Question: Write the caption for this figure.
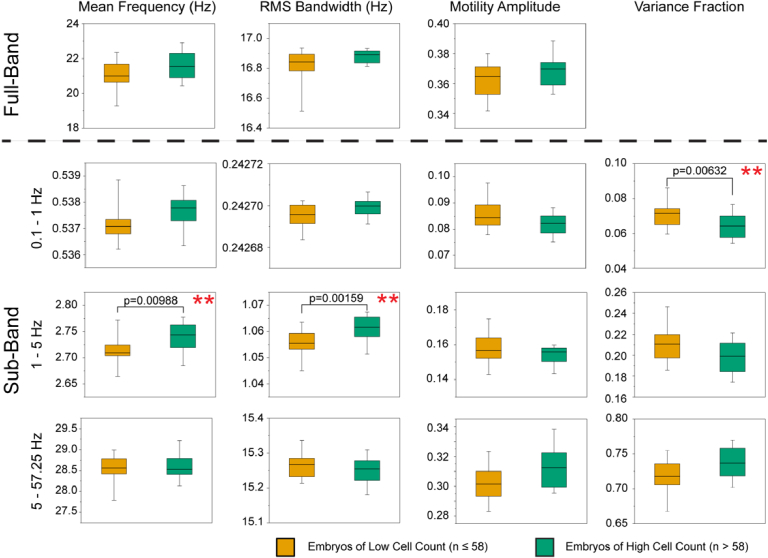
Answer: Comparison of band-resolved dOCM motility metrics between lower- and higher-cell-count blastocysts . Box plots illustrate the distribution of Mean Frequency, RMS Bandwidth, Motility Amplitude, and Variance Fraction derived from the full frequency spectrum (top row) and three distinct sub-bands: 0.1–1 Hz, 1–5 Hz, and 5–57.25 Hz. The cohort was stratified into two independent groups based on the median cell count: low-cell-count blastocysts (n ≤ 58, orange) and high-cell-count blastocysts (n > 58, green). Group differences were assessed using the two-tailed Mann-Whitney U test, with Benjamini-Hochberg False Discovery Rate (BH-FDR) correction applied across all 15 comparisons. Raw p-values are shown for statistically significant comparisons surviving BH-FDR correction (FDR < 0.05). Significance is indicated by red asterisks: ** p < 0.01 (FDR-corrected).